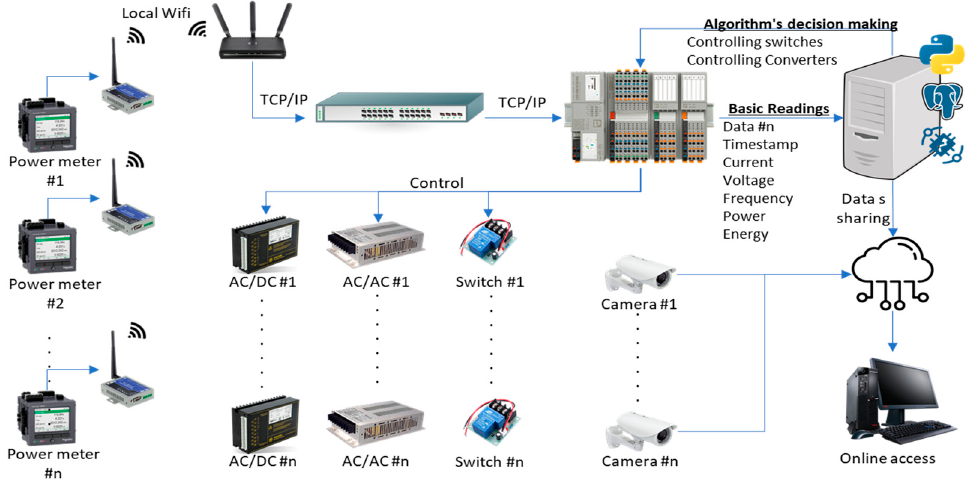
Figure 28. Conceptual architecture for test bench modules extensions and E-learning.